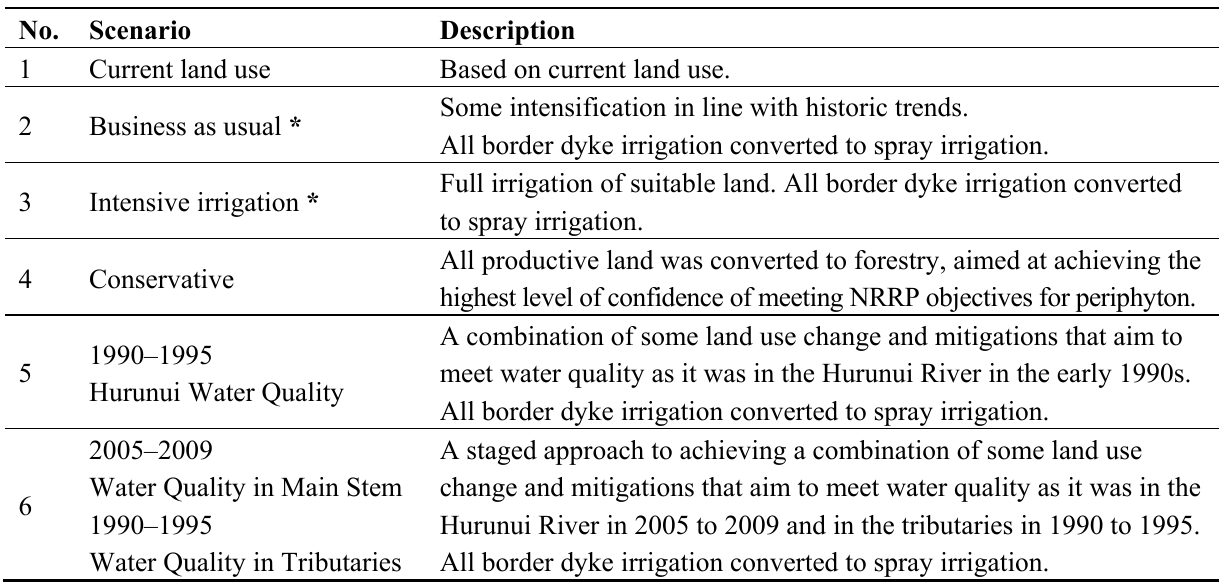
Table 1. Future land use